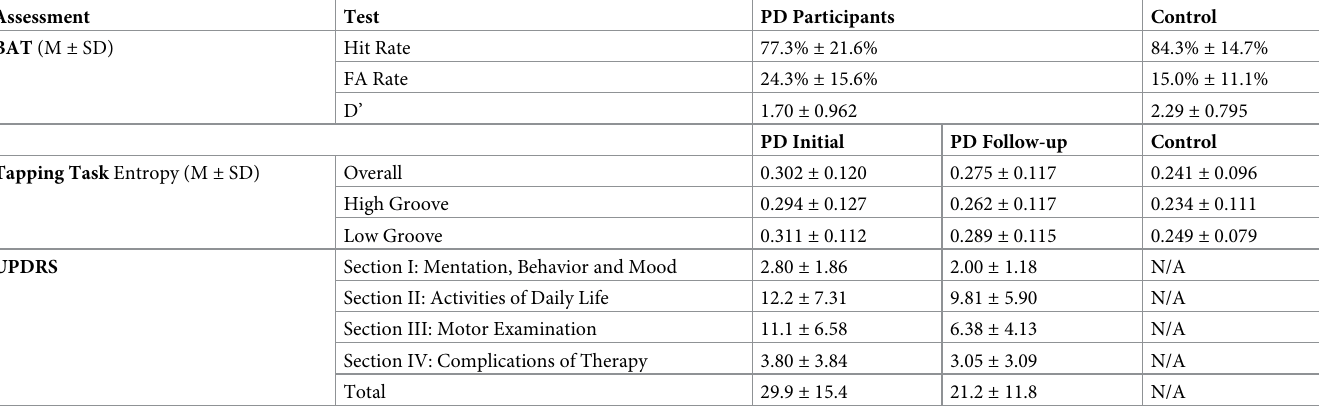
Table 2. Summary of key results from the BAT, tapping task (pre and post intervention), and UPDRS (pre and post intervention). Assessment